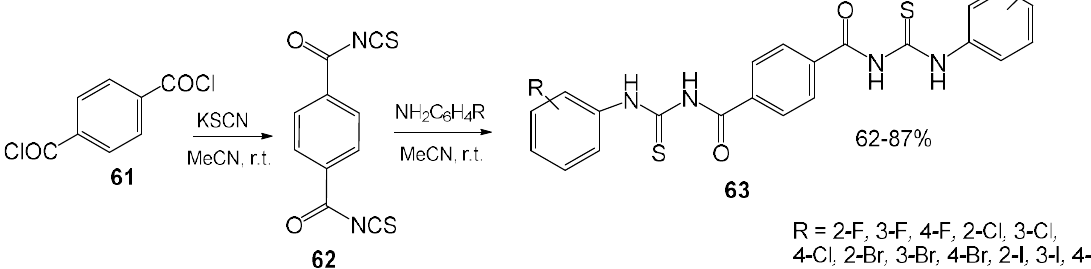
Fig. 18. Approaches to the synthesis of bis -(arylcarbamothioyl) tere-